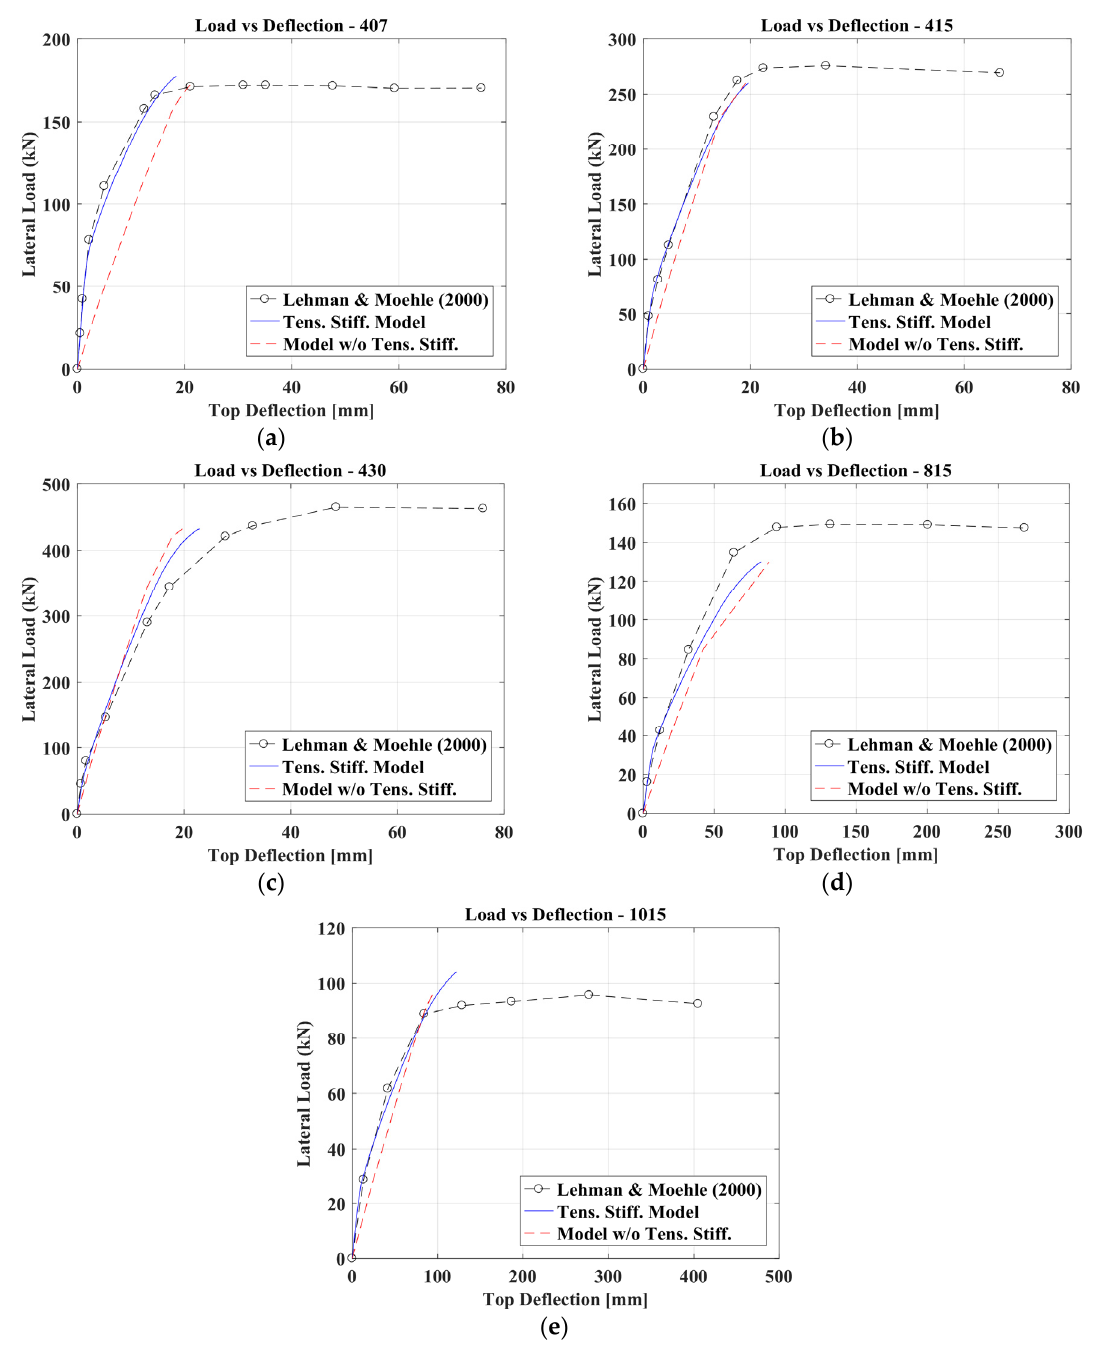
Figure 11. Comparison between the experimental results of Lehman and Moehle [26] and the numerical ones in terms of initial stiffness: Column IDs ( a ) 407, ( b ) 415, ( c ) 430, ( d ) 815 and ( e ) 1015